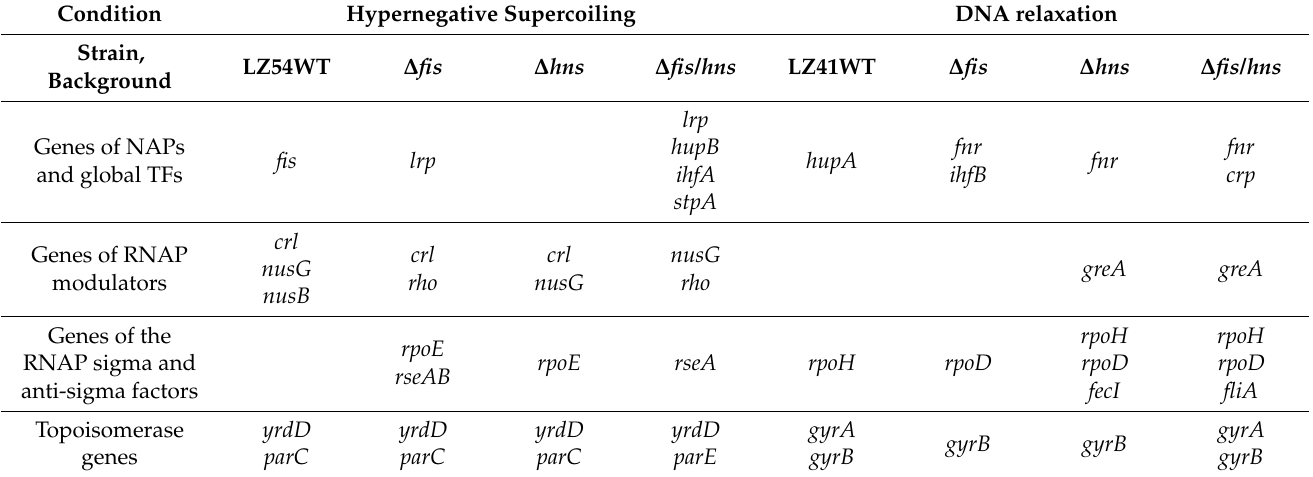
Table 1. Relevant genes up-regulated under conditions of norfloxacin-induced hypernegative DNA supercoiling and DNA relaxation in exponentially growing E.coli LZ54 and LZ41 wild-type (WT) strains and their mutant derivatives lacking the NAP-encoding genes fis , hns or both (data from [15] and unpublished